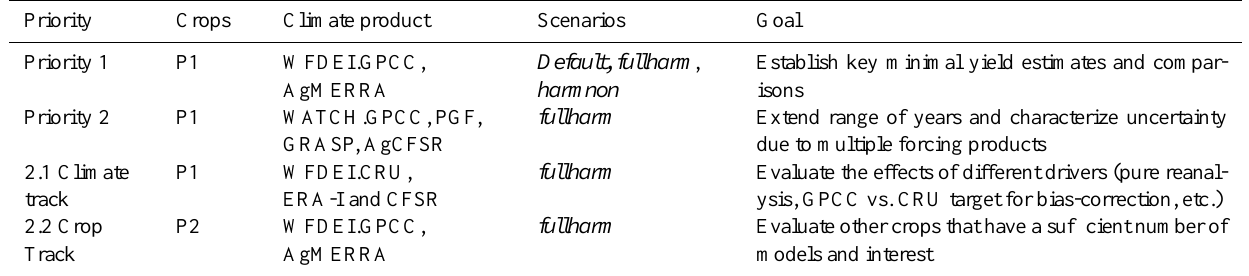
Table 5. Simulation priorities for Phase 1. For climate product descriptions see Table 9. Priority Crops Climate product Scenarios Goal Priority 1 P1 WFDEI.GPCC, Default, fullharm , Establish key minimal yield estimates and compar- AgMERRA harmnon isons Priority 2 P1 WATCH.GPCC, PGF, fullharm Extend range of years and characterize uncertainty GRASP, AgCFSR due to multiple forcing products fullharm Evaluate the effects of different drivers (pure reanal- ysis, GPCC vs. CRU target for bias-correction, etc.)